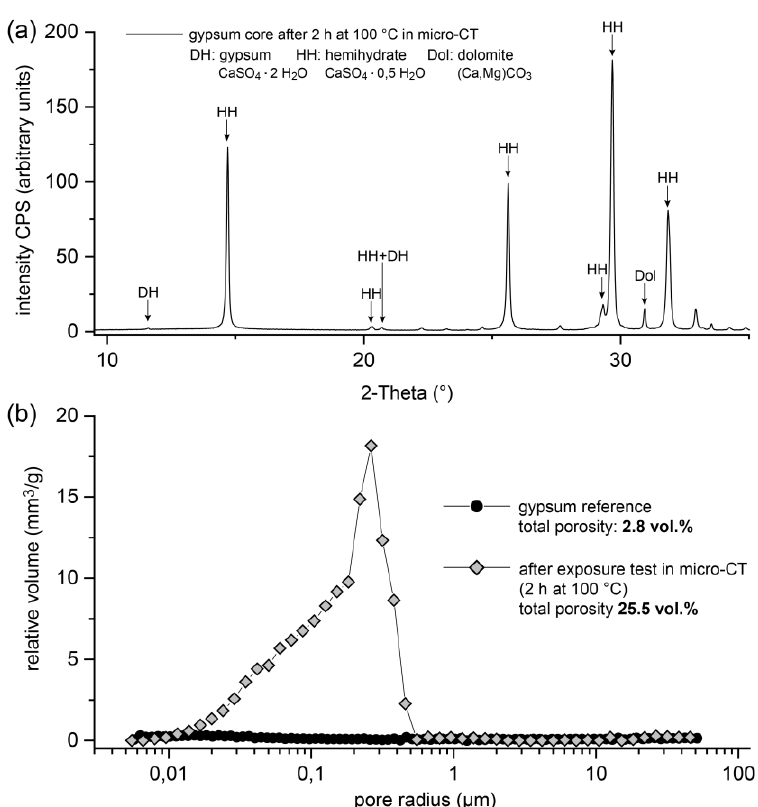
Figure 4. XRD measurement ( a ) and results of the investigation of the pore structure by mercury intrusion porosimetry (MIP) ( b ) of the sample directly after micro-CT tests (2 h at 100 °C). The MIP results are contrasted with the measurement of an untreated reference sample.